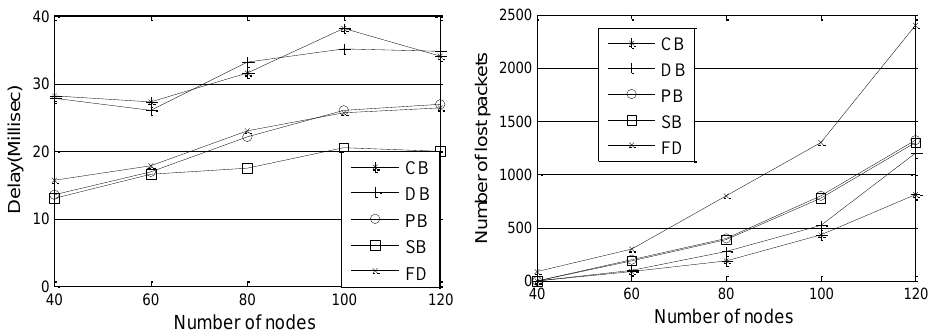
Fig. 3. Comparison of end to end delay. Fig. 4. Comparison of lost packets by